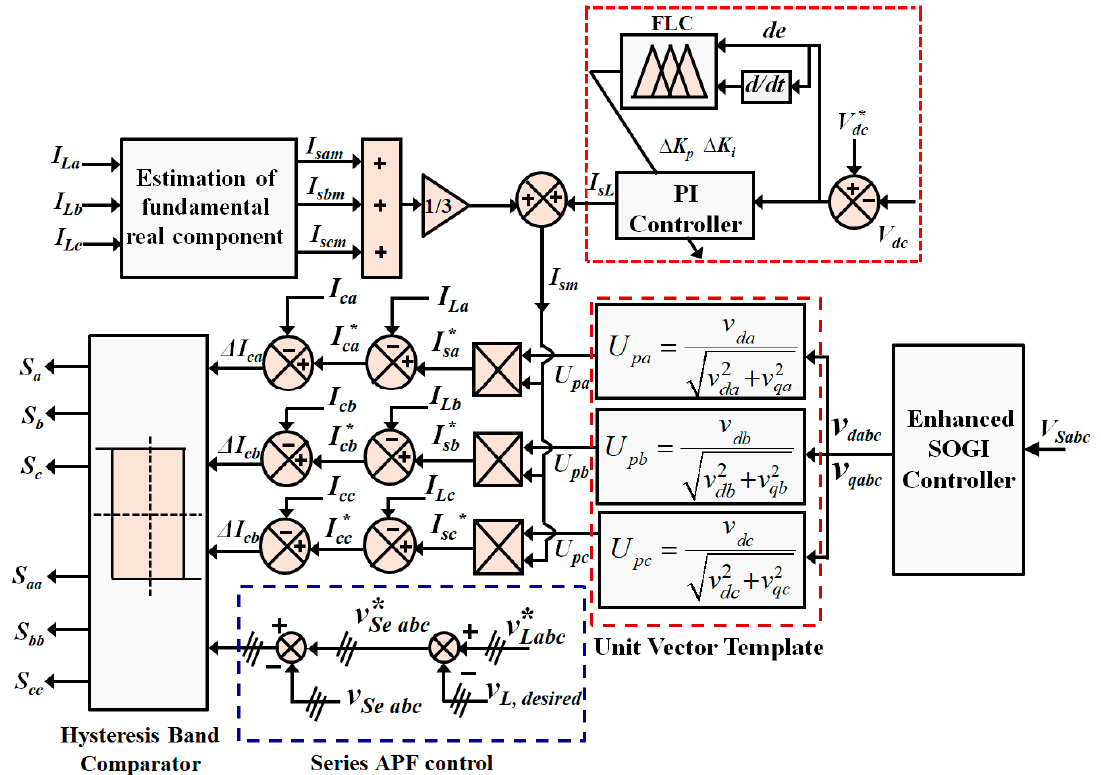
Figure 6. Block diagram of the enhanced SOGI based control algorithm for the solar photovoltaic-unified power quality conditioner.